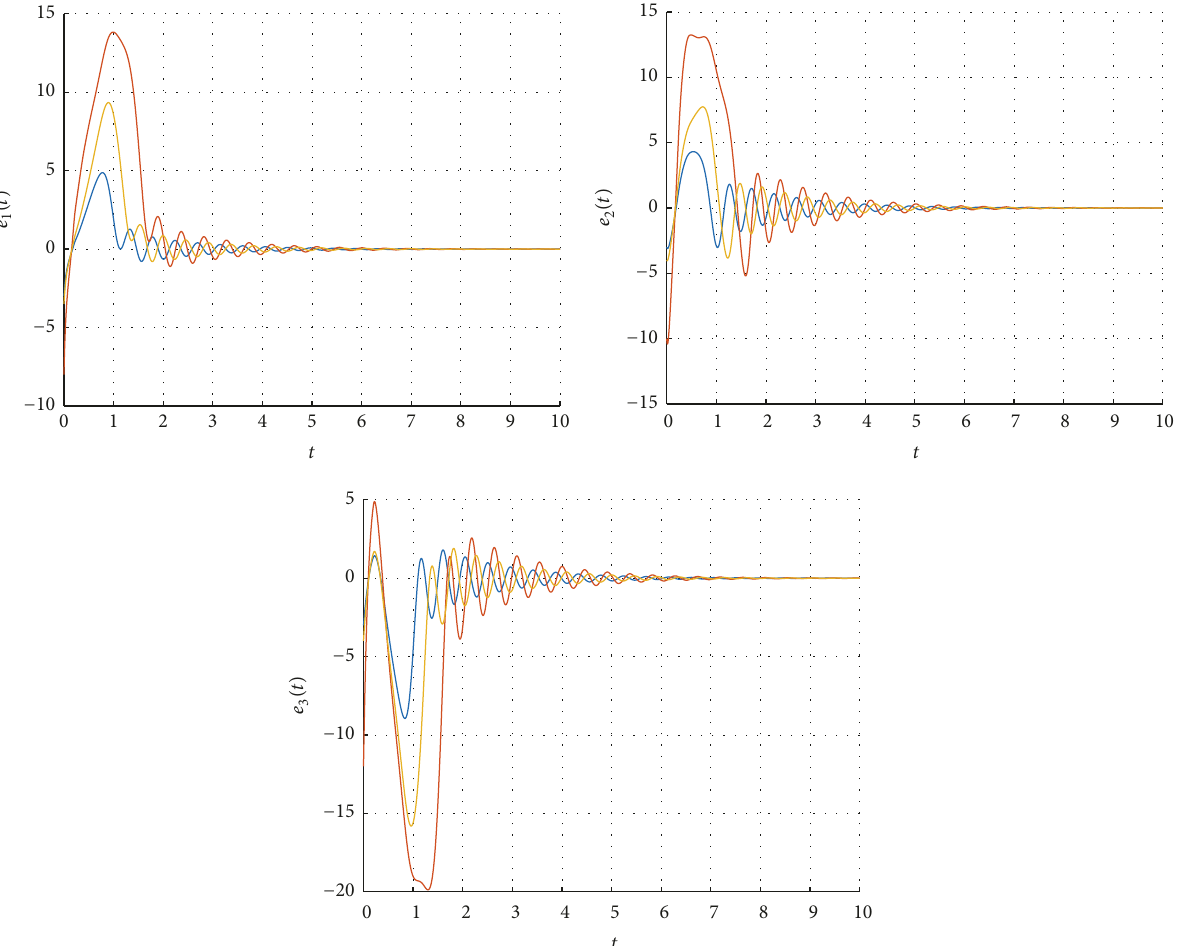
Figure 4: Synchronization errors in an example: 𝑒 𝑗 (𝑡) = 𝑥 1𝑗 (𝑡) − 𝑥 𝑖𝑗 (𝑡) for 𝑖 = 2, 3, 4, 𝑗 = 1, 2,3